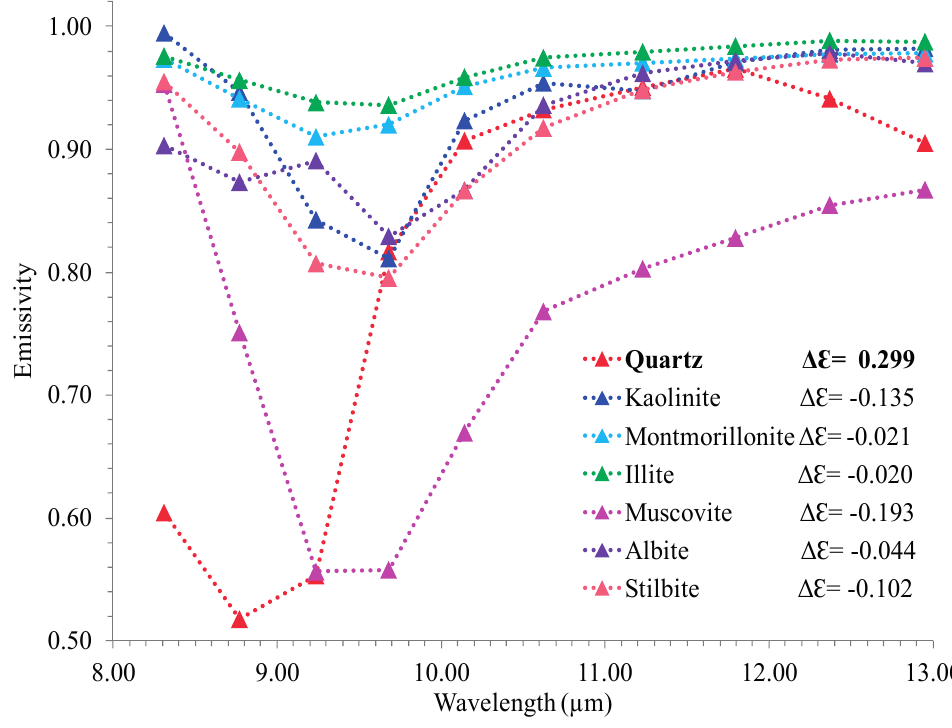
Figure 9. Emissivity spectra of some silicates based on the Arizona State University spectral library [37] and resampled to the AHS spectral